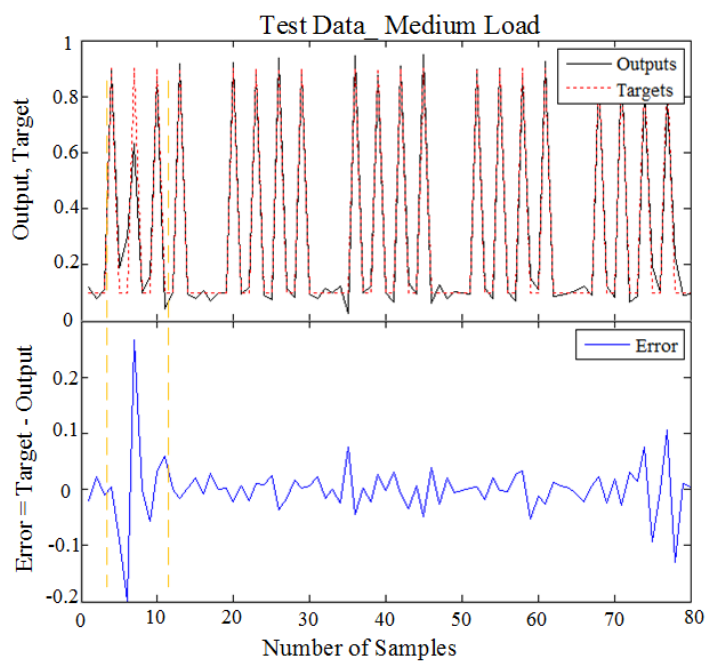
Figure 14. The Error between Real Output and Desired for Testing Data Set in 50% of Full Load.